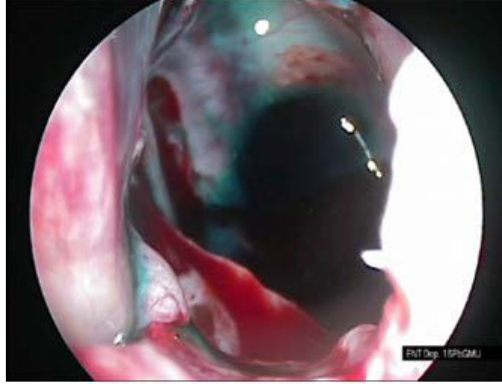
Figure 3. Colored mucosa of the sphenoid